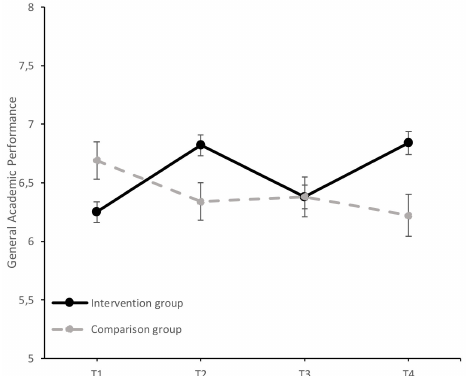
Figure 2. Evolution of the average AP scores ( ± SEM) in the intervention and comparison groups over time (T1 = baseline; T2 = at the end of the first year of intervention; T3 = follow-up after the first year of intervention; T4 = at the end of the second year of intervention).